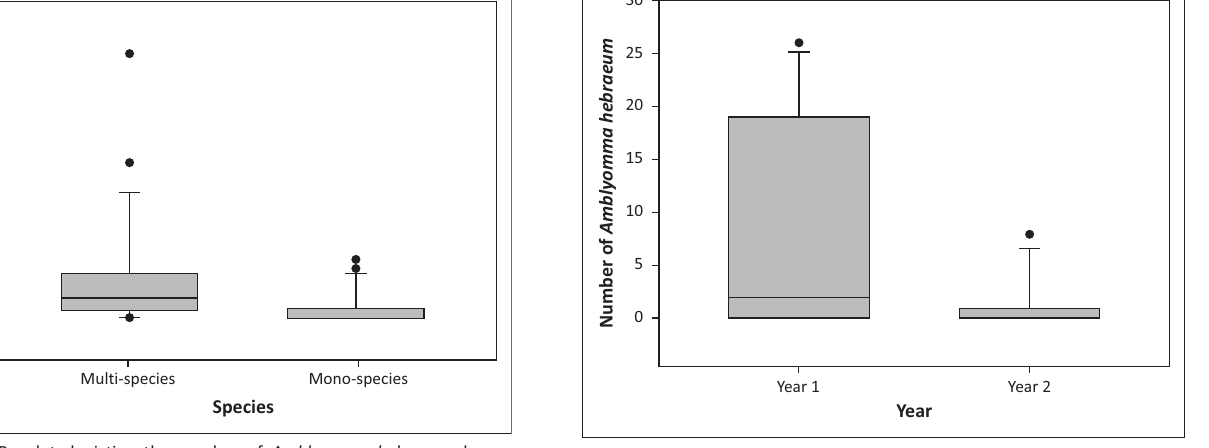
FIGURE 7: Boxplot depicting higher numbers of Amblyomma hebraeum larvae collected from the vegetation in the woodland in the sable antelope breeding whiskers refer to the median, the interquartile range and the interoctile (80 % ) range, whilst the dots are extremes or